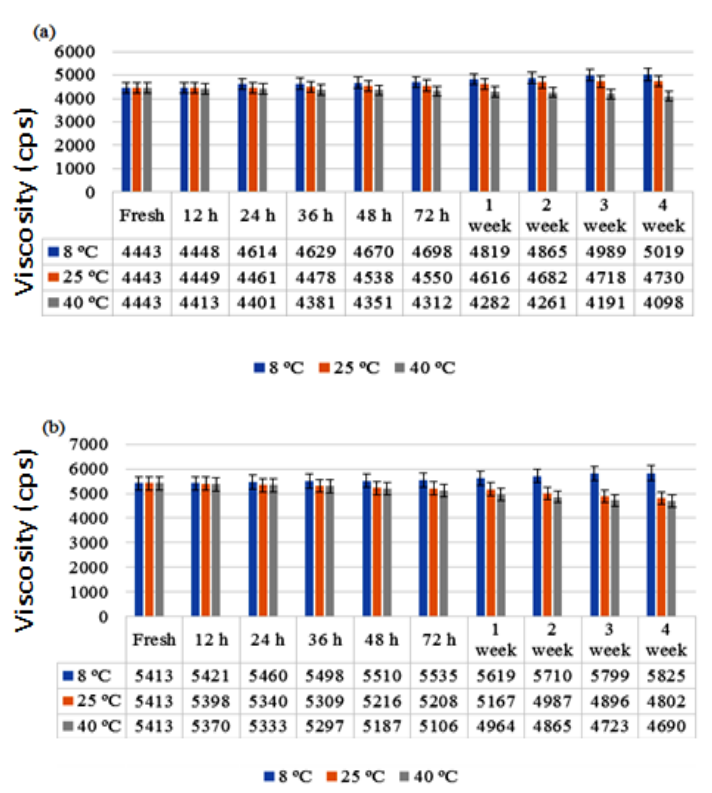
Figure 2. Viscosity of formulations ( a ) C1 and ( b ) C2 over 28 days.